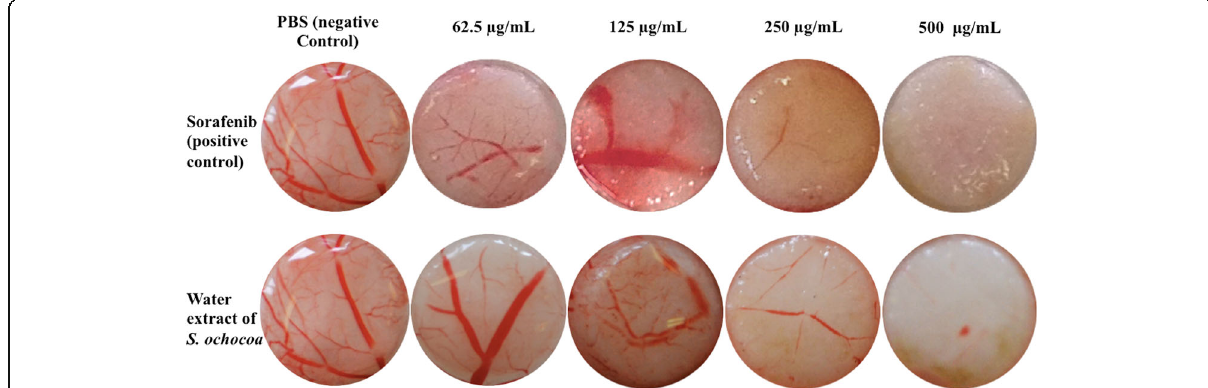
Fig. 2 Inhibitory effects of water extracts of plants on angiogenesis. The CAM of a 8 days old chick embryo was separately exposed to PBS (control). Extracts were introduced on top of the CAMs. After 48 h of incubation, the CAM tissue directly beneath each filter disk was resected, and digital images of the CAM sections were